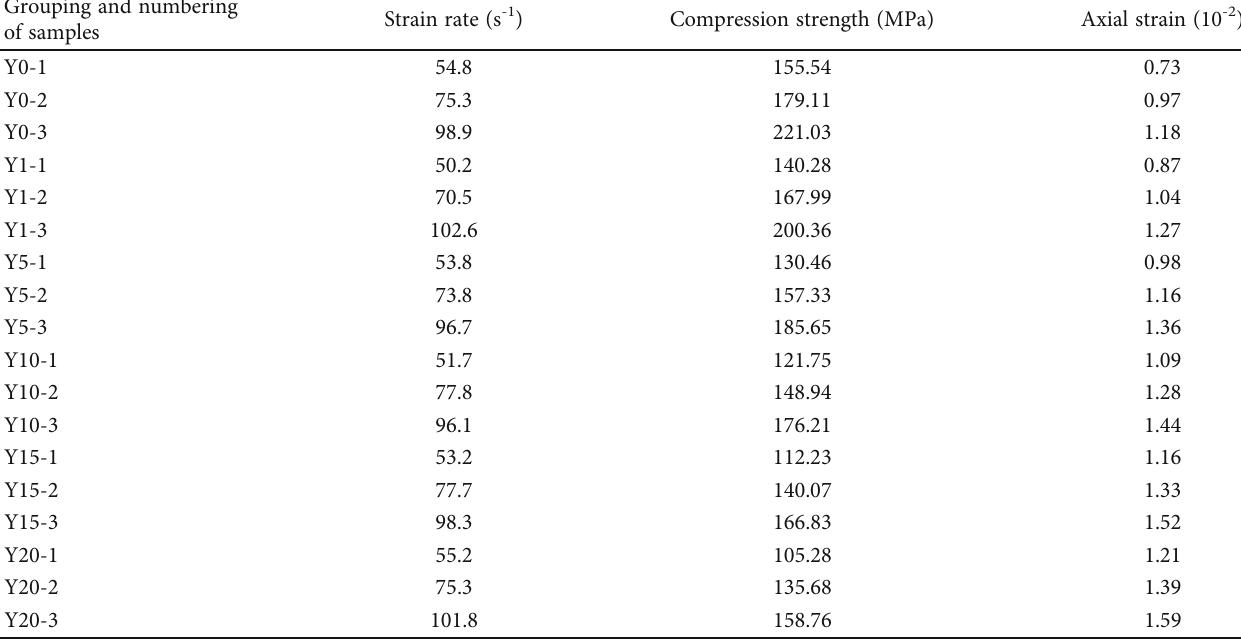
Table 3: Dynamic uniaxial compression mechanical parameters of sandstone under di ff erent freeze-thaw